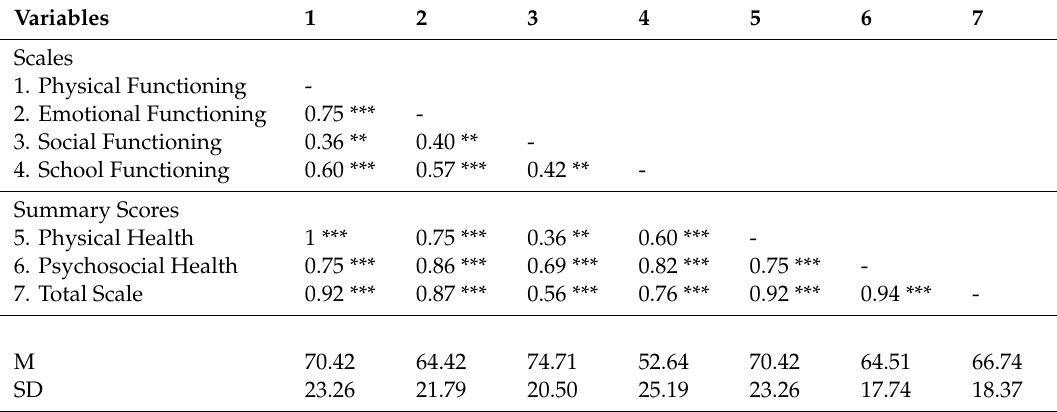
Table 2. Description of the Scores on Pediatric Quality of Life Inventory (PedsQL).